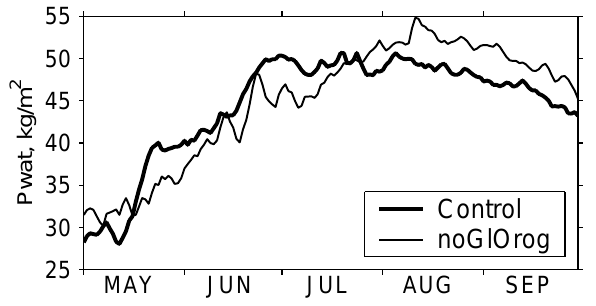
Fig. 7. Evolution of P wat (kg m − 2 ) over the Indian region in control and noGlOrog